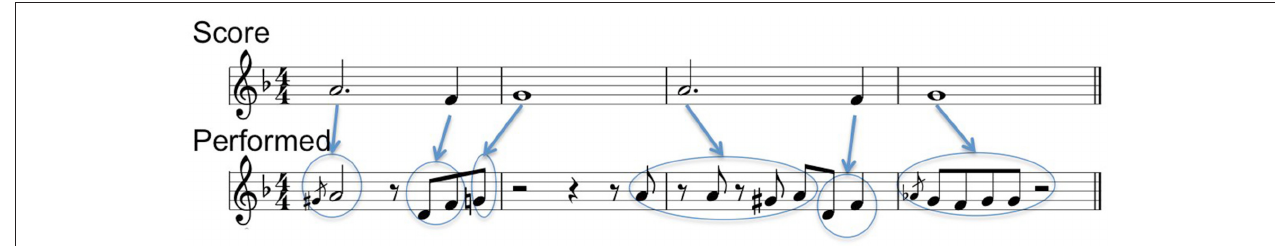
FIGURE 3 | Parent score notes (top) to performance notes (bottom) alignment